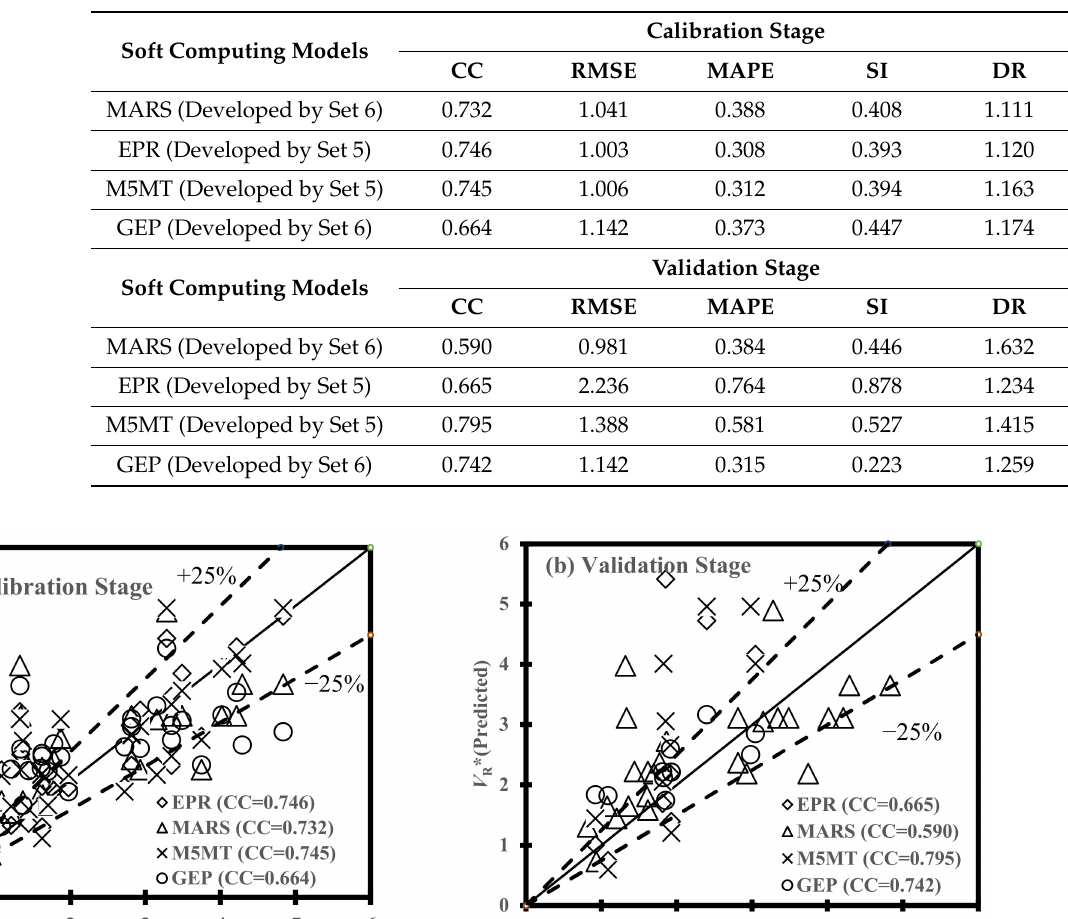
Table 13. The best statistical performances of the soft computing models for prediction of V R *.